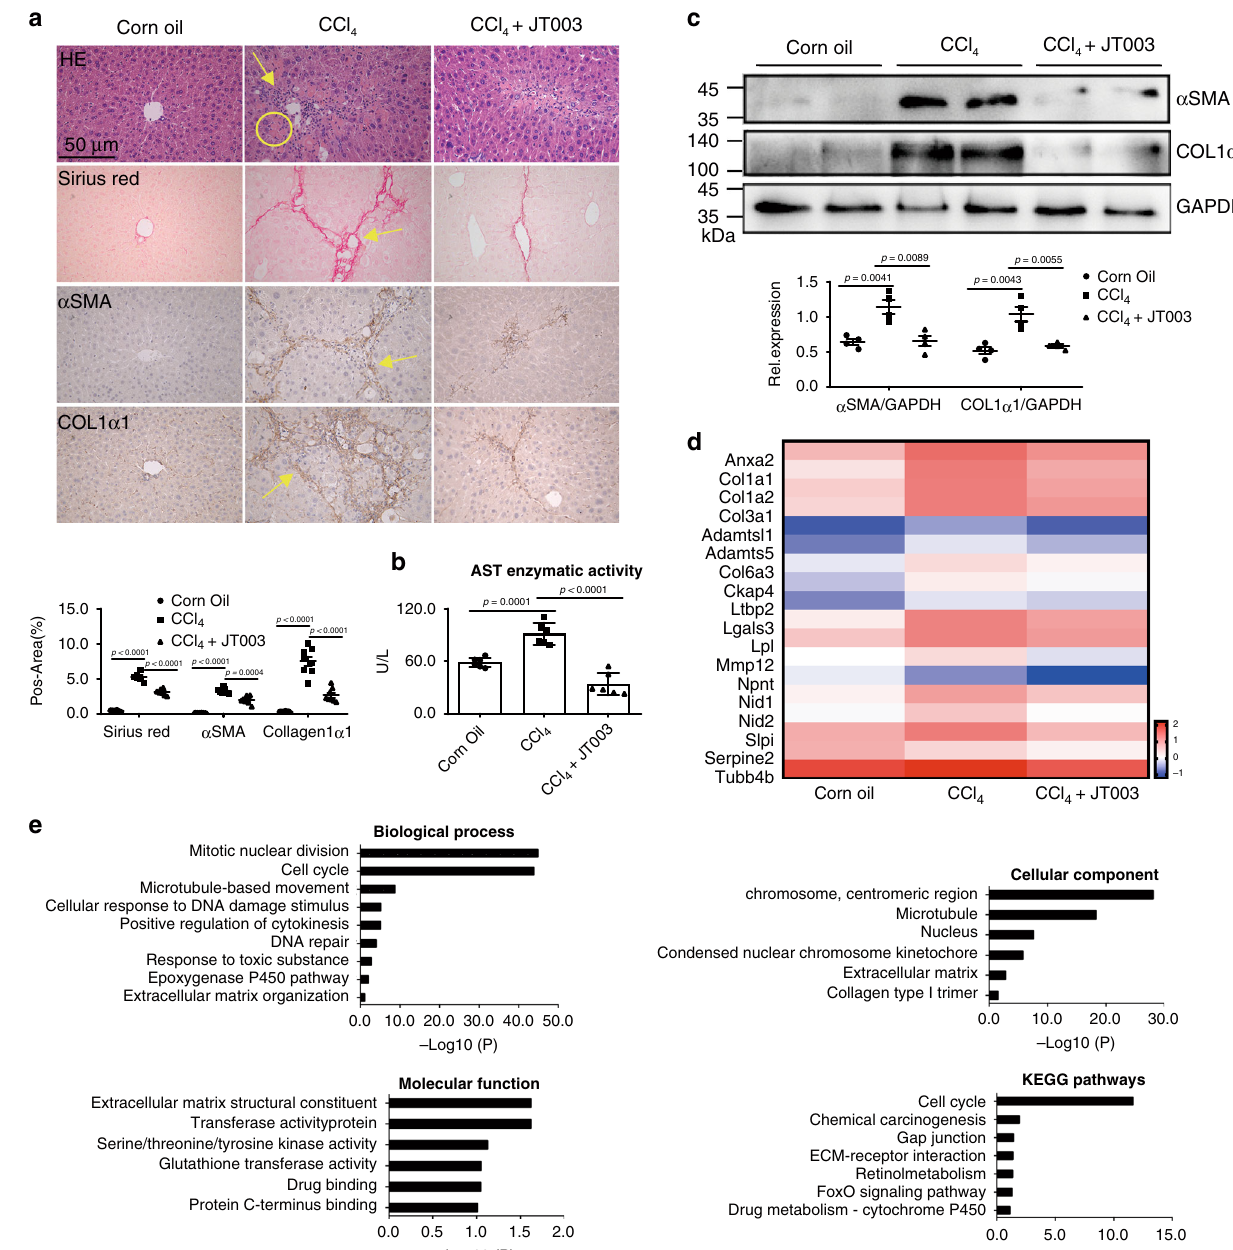
Fig. 5 JT003 inhibits the progress of CCl 4 -induced liver fi brosis. a , b Representative images of HE staining, sirius red staining and IHC for α SMA and COL1 α 1 of liver sections and ALT activity on mice treated with Corn Oil, CCl α SMA and COL1 α 1 4 or CCl 4 plus JT003 therapy. c Western blotting assay of measured in liver samples of mice treated with Corn Oil, CCl 4 or CCl 4 plus JT003 therapy. GAPDH serves as the loading control. d The fi brogenesis-related genes that signi fi cantly up-regulated or down-regulated in RNAseq analysis (q < 0.001). e GO and KEGG pathway analysis. For in vitro experiment, the concentration of JT003 is 200 μ M. For the in vivo experiment, the dose of JT003 is 500 μ g kg − 1 . Here and later, for each assay, three separated experiments were performed. And for each experiment ( n = 4 cell samples/group or n = 6 mice/group). For the in vivo experiment, the dose of JT003 is 500 μ g kg − 1 . All the above data are presented as mean values ± SEM using unpaired Student ’ s t test. Source data are provided as a Source Data fi